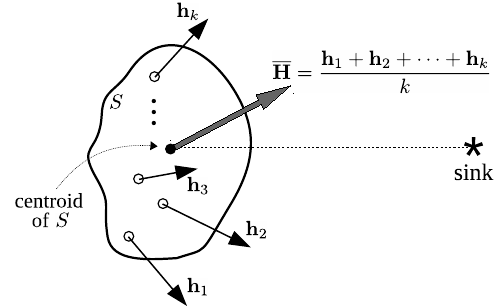
Figure 5. Average hop of an area S for a network instance (a single execution of the random